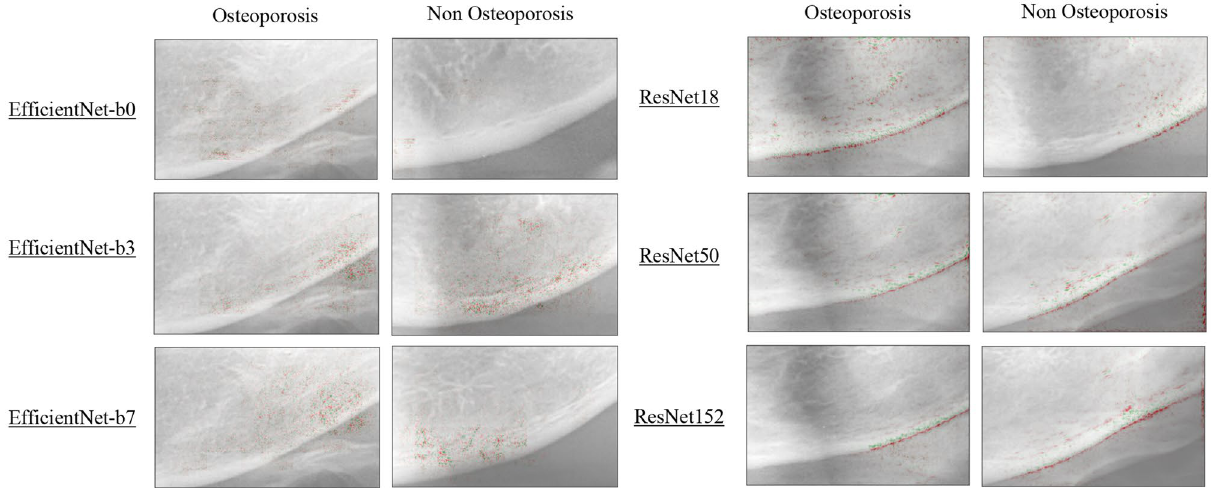
Figure 1. Visualization of characteristic regions of radiographs of osteoporosis and non-osteoporosis patient images using ResNet and